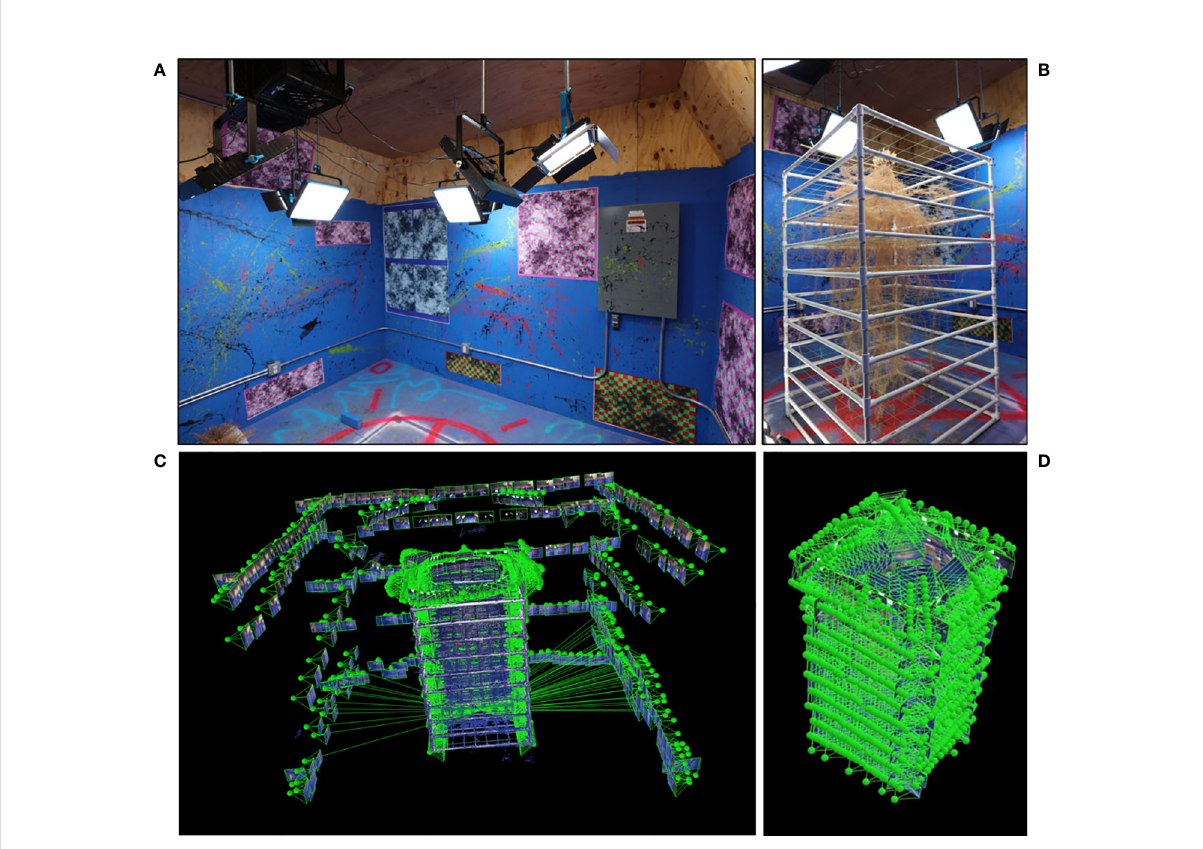
FIGURE 4 Photogrammetry studio and imaging process. Photogrammetry requires a dedicated space with many unique identi fi cation markers and strong uniform illumination (A) . Plants samples are placed centrally in the studio to minimize shadows (B) . Images are taken surrounding the subject (small rectangles are locations of individual camera locations) at several elevations to provide data to form the environment (C) . Close up images are taken surrounding the root system with very high overlap to produce maximum system detail (D)